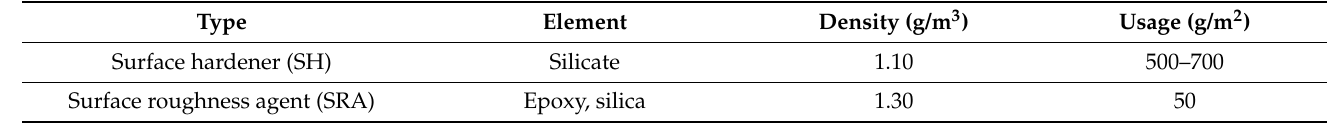
Table 8. Properties of the infrared thermometer used in this Figure 2. Procedure of ATMS. ( a ) Cleaning surface with sand blasting; ( b ) Surface hardener (SH); ( c ) Surface roughness agent (SRA); ( d ) ATMS. Table 7. Physical properties of SH and SRA.